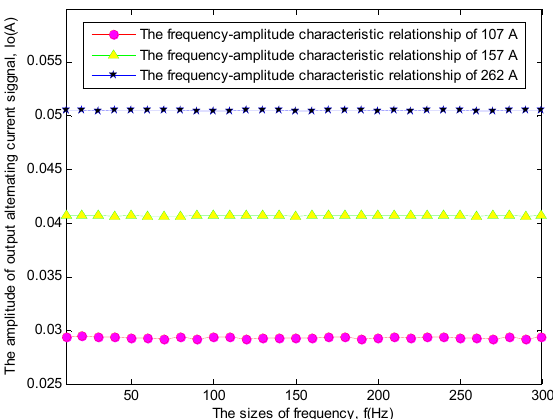
Figure 14. The frequency-amplitude characteristic relationship of this sensitivity-enhanced current sensor. The red curve with some magenta solid circles shows the frequency-amplitude characteristic relationship of the alternating current excitation signal of 107 A. The green curve with some yellow solid triangles shows the frequency-amplitude characteristic relationship of the alternating current excitation signal of 157 A. The blue curve with some black solid five-pointed stars shows the frequency-amplitude characteristic relationship of the alternating current excitation signal of 262 A.